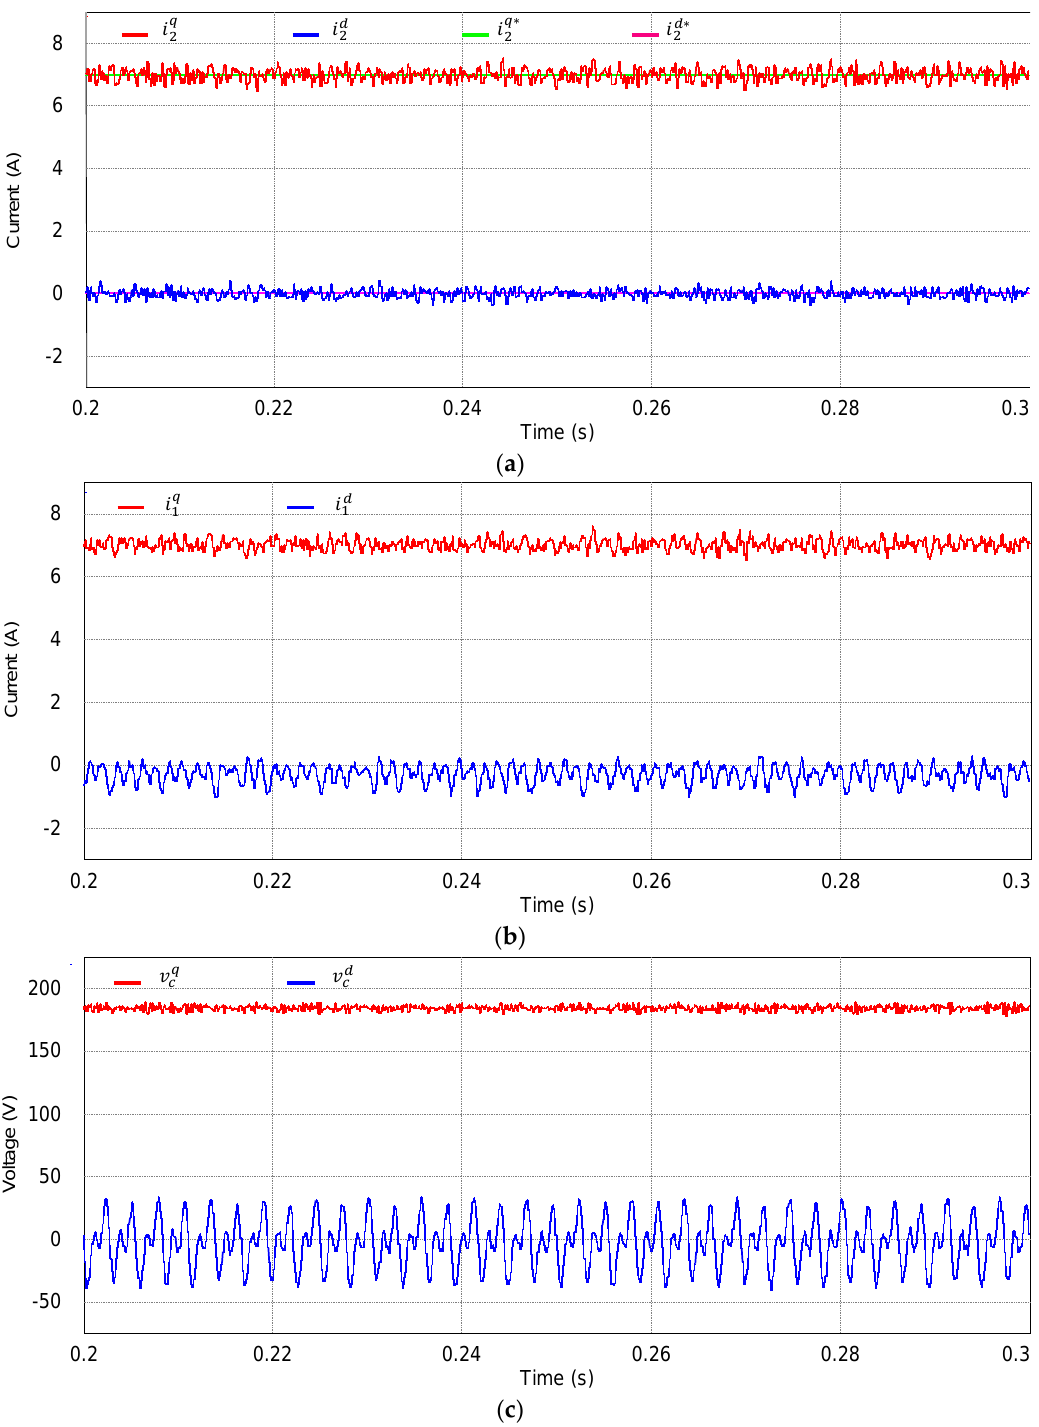
Figure 6. Simulation results for steady-state responses under distorted grid voltage with the proposed controller. ( a ) Grid-side current responses at the synchronous reference frame (SRF); ( b ) Inverter-side current responses at the SRF; ( c ) Capacitor voltage responses at the SRF.